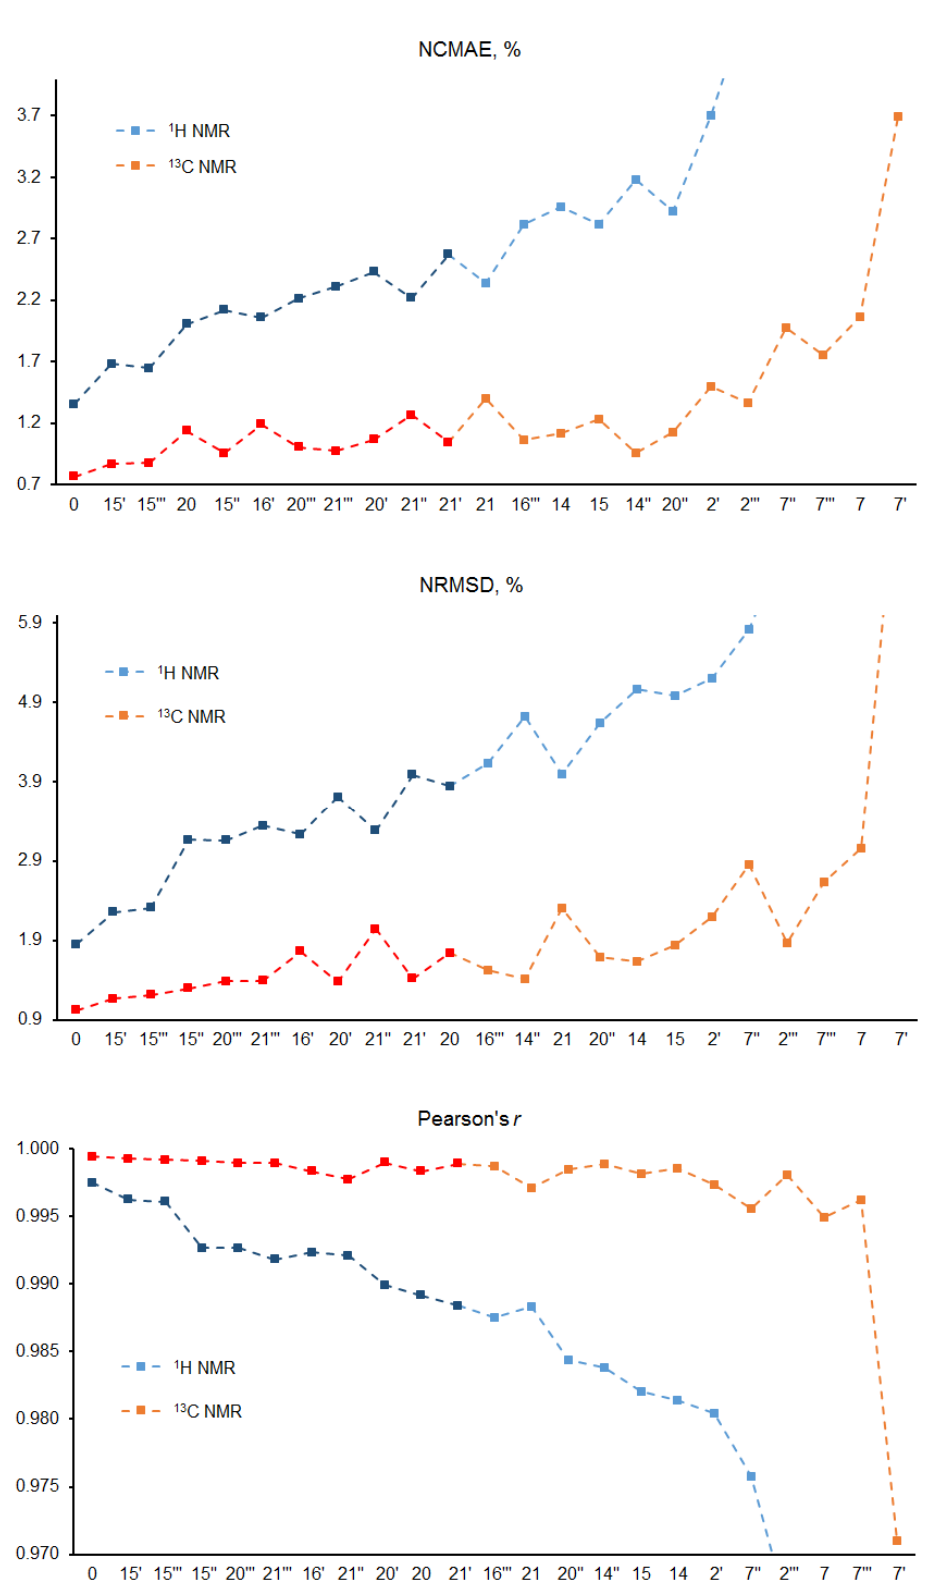
Figure 6. Normalized CMAE (%), normalized RMSD (%), and Pearson’s correlation coefficient for the “main” diastereomers of alasmontamine A. Based on the deviations of these descriptors, as many as six principle stereocenters of alasmontamine A were established. The alteration of the configuration of each of those